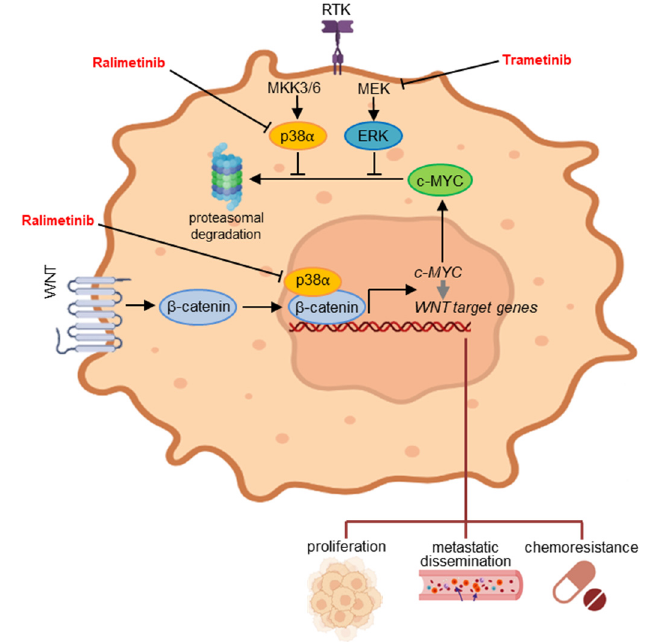
Figure 8. c-MYC is one of the most important factors in CRC and is maintained upregulated through β -catenin-mediated transcriptional activation and ERK-mediated post-translational stabi- lization. Our previous and current findings indicate that p38 α , a kinase involved in CRC metabolism and survival, contributes to both mechanisms. As a result, the p38 α inhibitor ralimetinib may prove effective in impairing cellular proliferation, reducing metastatic dissemination and overcoming chemoresistance in CRC.